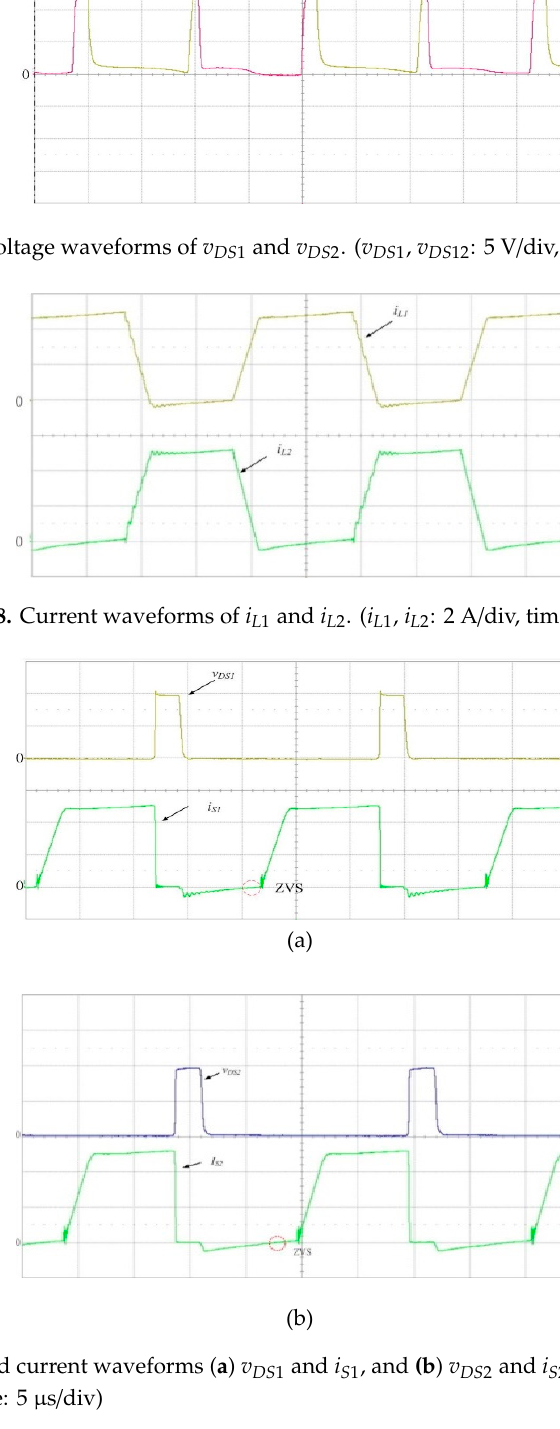
Figure 6. Control circuit.